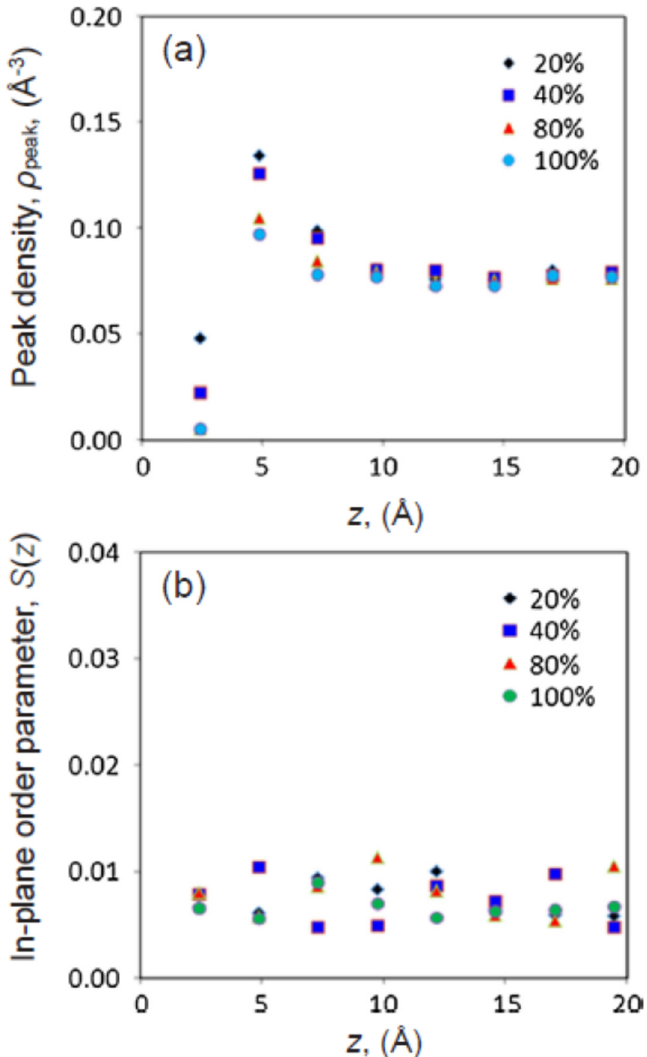
Figure 15. Effect of surface roughness of the amorphous substrate on atomic ordering [25]. ( a ) ρ p ( z ) and ( b ) S ( z ) of the liquid Al adjacent to the interface are plotted as functions of distance from the interface and surface roughness, R , in the simulation system with a single layer of amorphous substrate, equilibrated at 1000 K. L1 has a relatively low peak density, which accounts for the liquid atoms occupying a fraction of the atomic positions in the surface layer of the substrate. The layering of the liquid at the interface deteriorates with increasing R , and there is no visible in-plane atomic ordering regardless of R . (Reprinted with permission from Ref. [25]. 2022, Elsevier.)